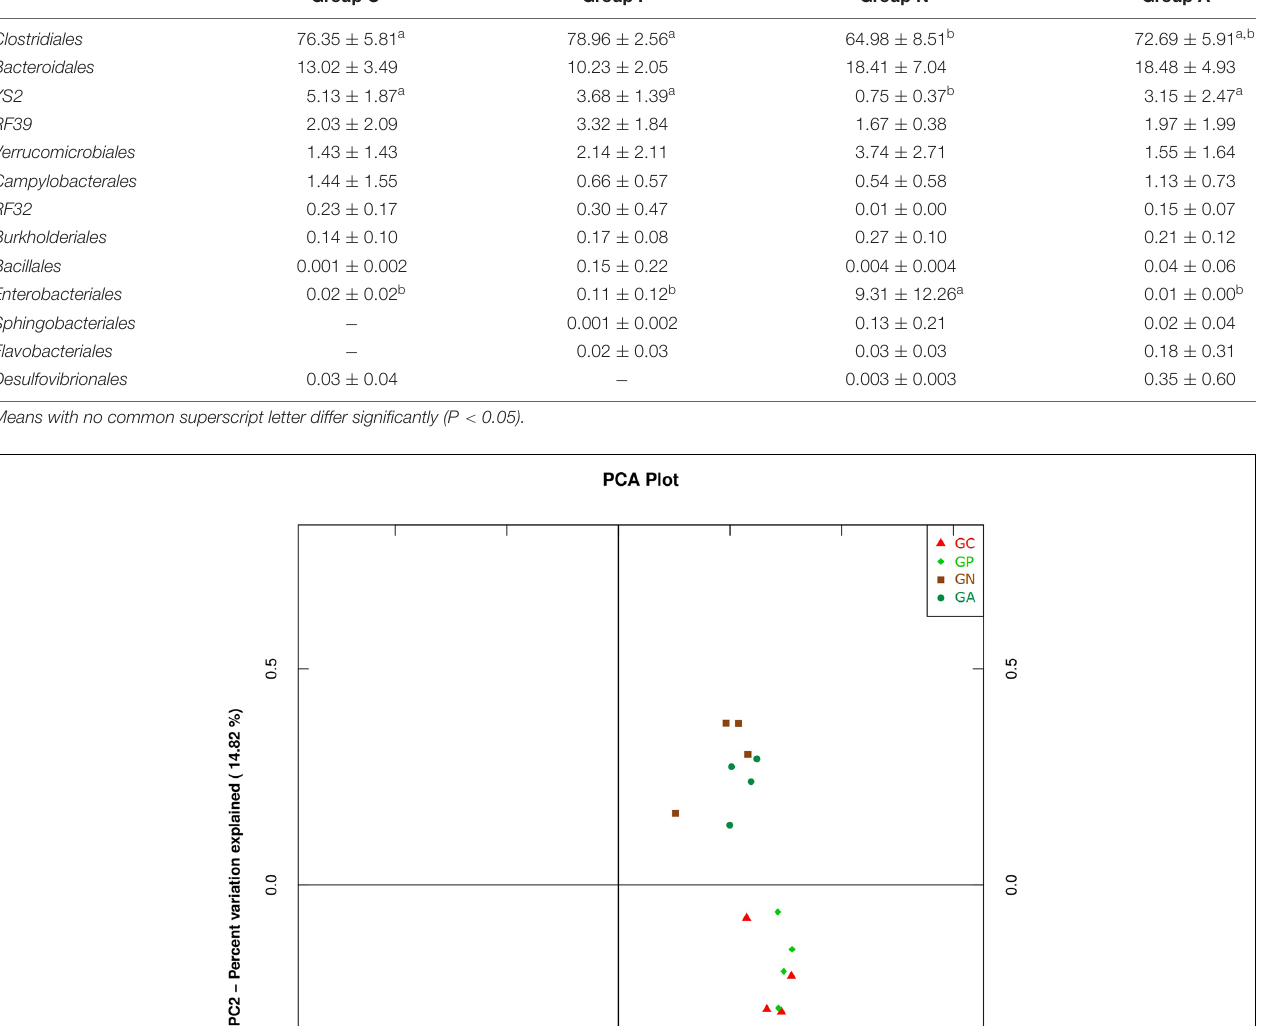
TABLE 4 | Influence of different treatments on the bacterial core order relative abundance (%) in all groups (Mean ± SD). Group C